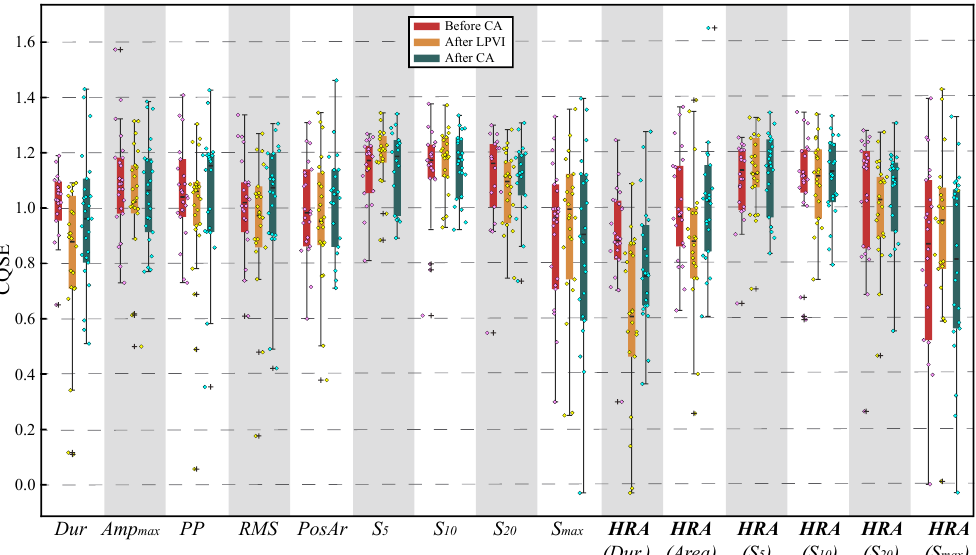
Figure 5. Combined box and whiskers plot with scatterplot for CQSE between surface and invasive features before ( left ), after LPVI ( centre ), and after full CA ( right ). Dur : Duration